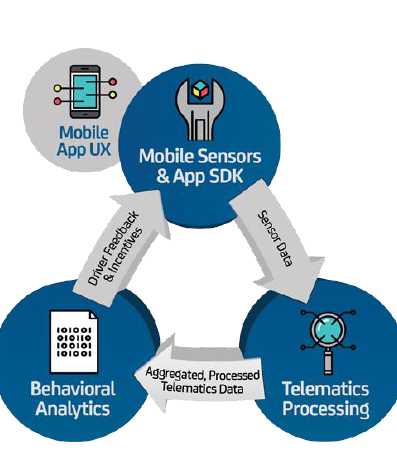
Figure 2: Architecture of DriveWell Application. The use of behavioural analytics and nudge theory can be used to improve driver's behaviour.